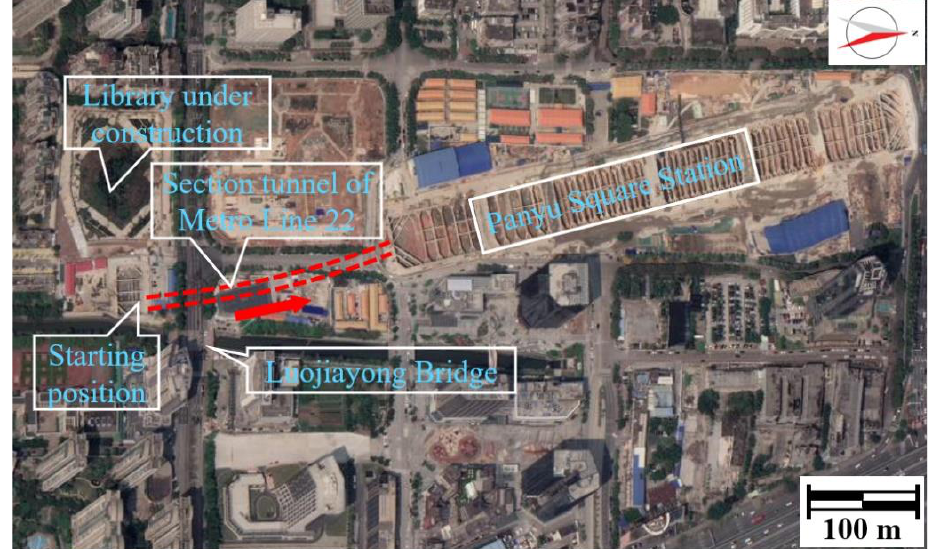
Figure 23. Surrounding environment of section tunnel